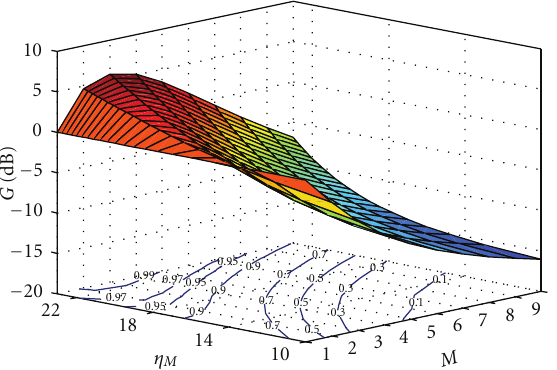
Figure 1: Achievable processing gain based on antenna blocking with M orthogonal blocking functions, P F 0 = 0 . 01, and various values of available SNR ( η M ). The contour curves show the corresponding P D 0